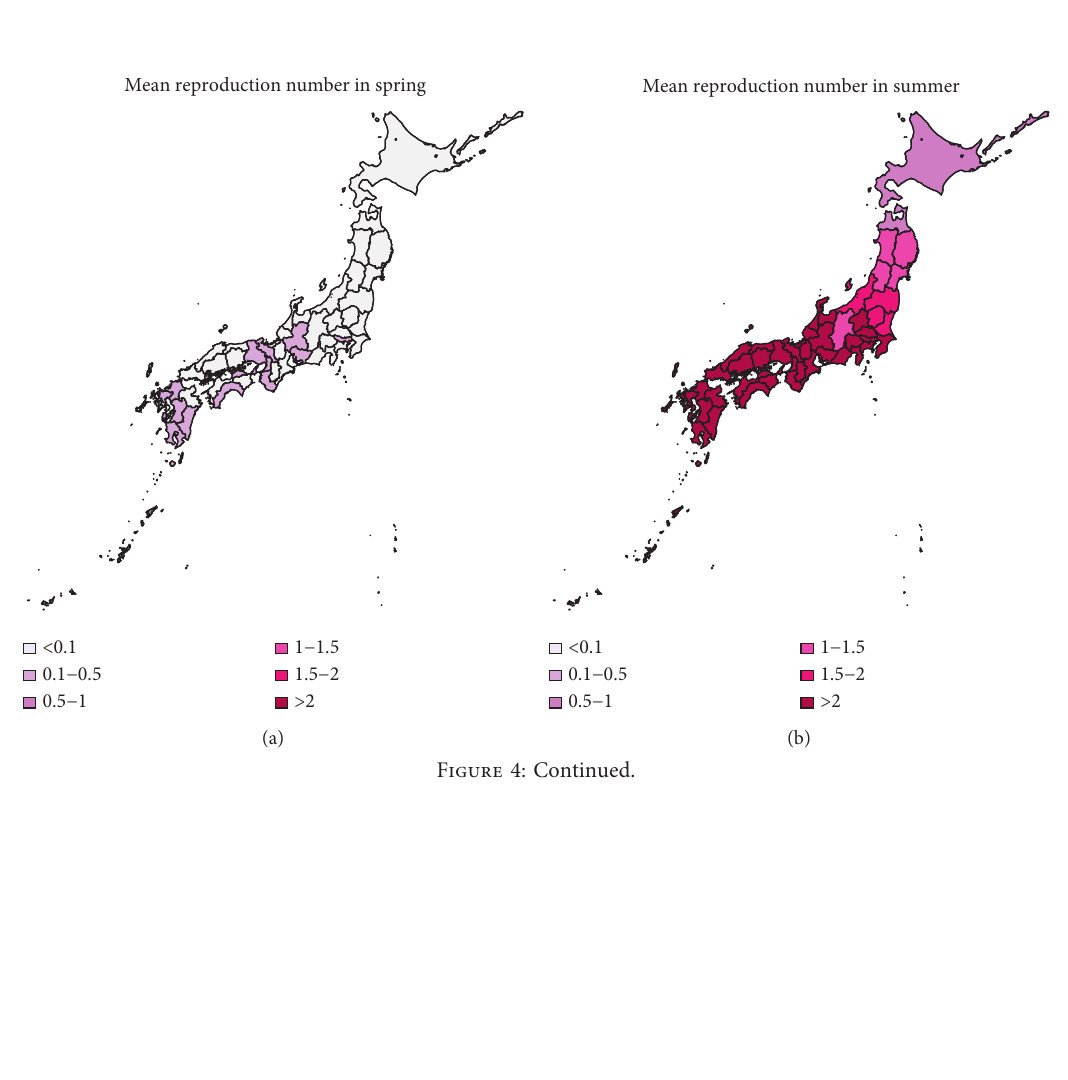
Figure 3: (a) Seasonality of the effective reproduction number of Tokyo. (b) The probability of extinction when the infectious individual is imported in June. (c) The probability of extinction in November versus importation